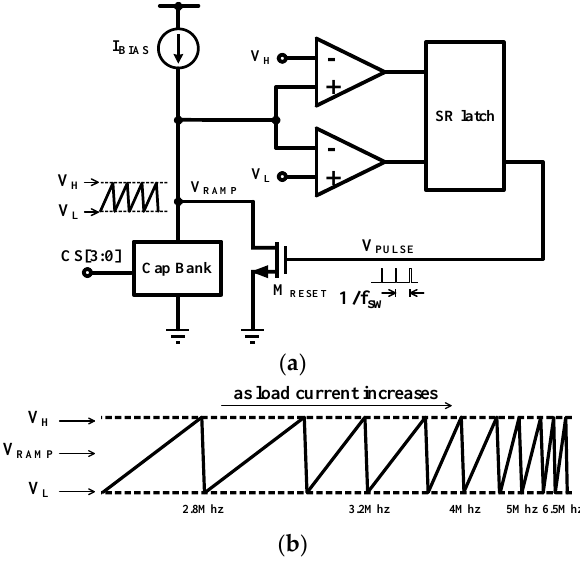
Figure 6. Adaptive frequency ramp generator: ( a ) schematic and ( b ) ramp waveform.